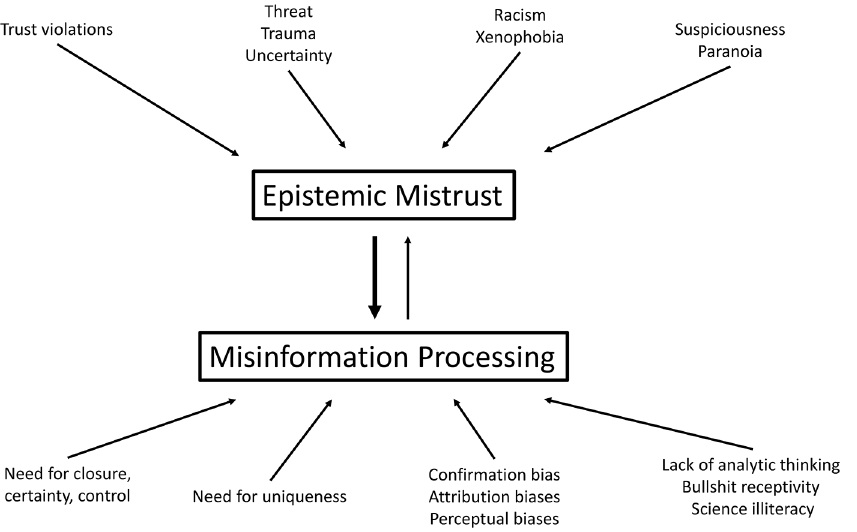
Figure 1. The two-component, socio-epistemic model of belief in conspiracy